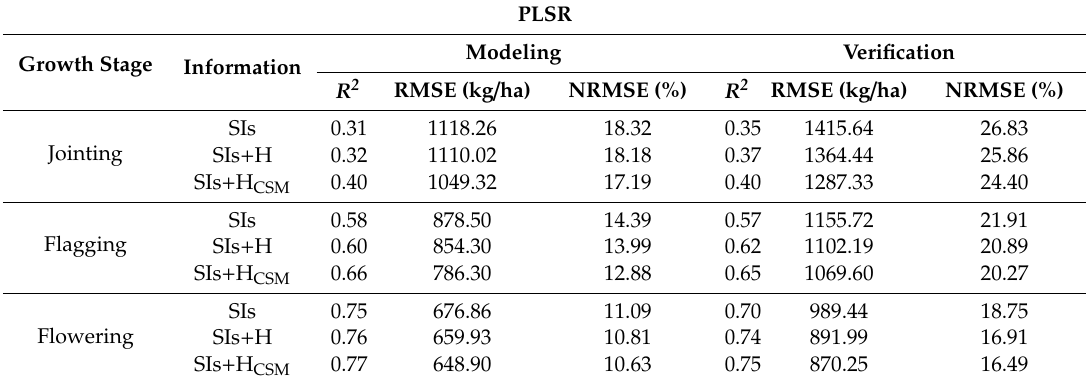
Table 4. Results of the estimation of the yield of winter wheat in di ff erent growth stages by using partial least squares regression (PLSR).